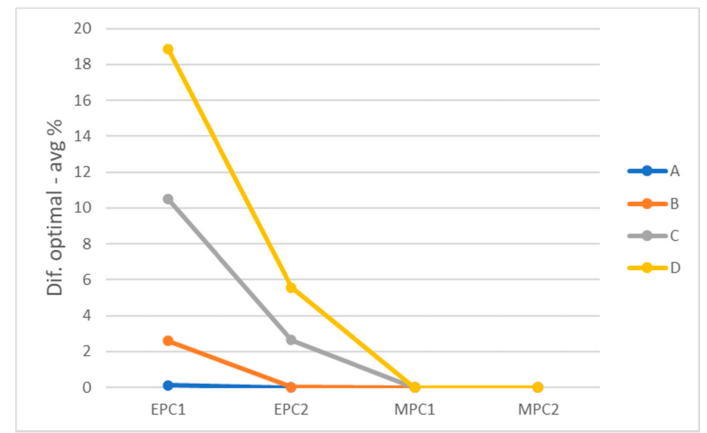
Figure 9. Dif. optimal-avg for different configurations.